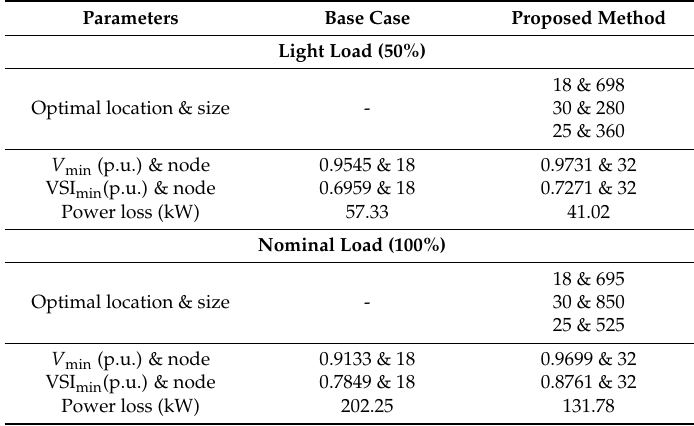
Table 1. Results achieved by the suggested method (at loads 50%, 100%,